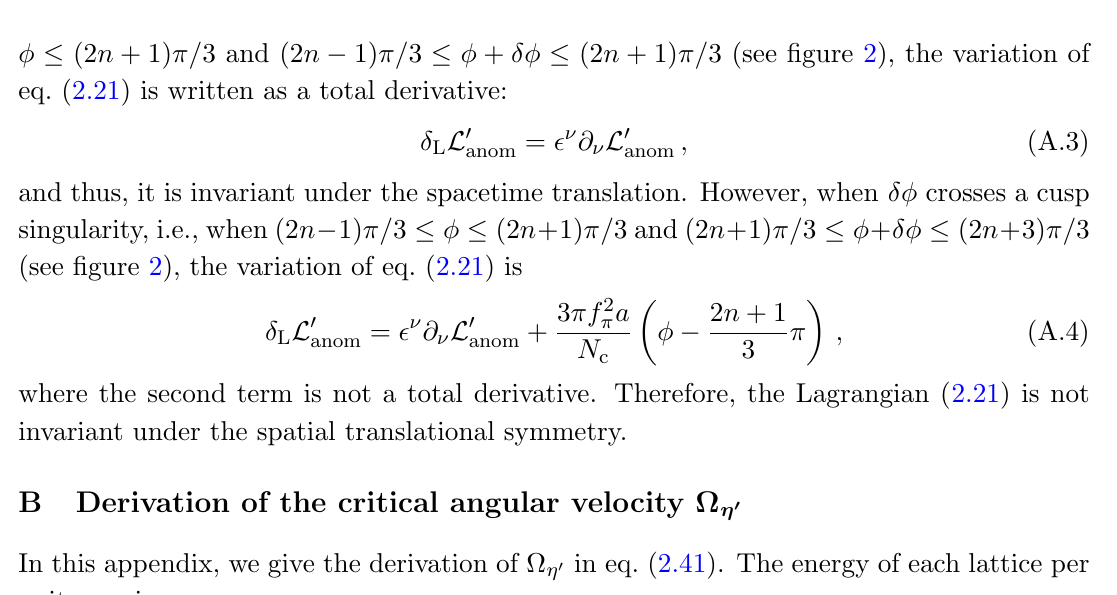
Figure 1 . V anom as a function of (cid:30)